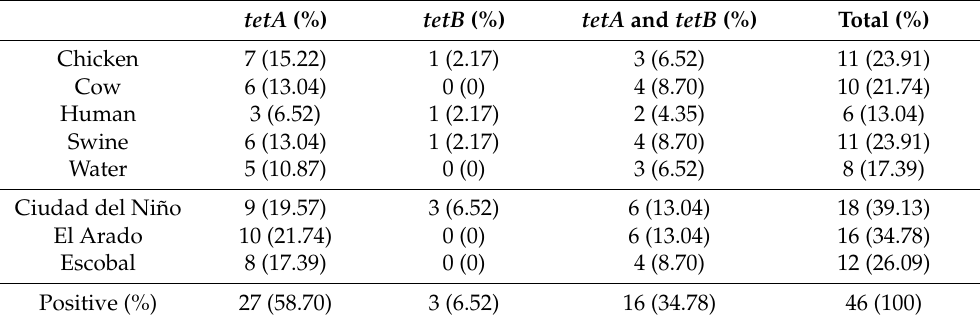
Table 2. Detection of tetA and/or tetB in the samples analyzed in this study. The number of positive isolates and the corresponding percentage (in parenthesis) are indicated per sample source and sampling